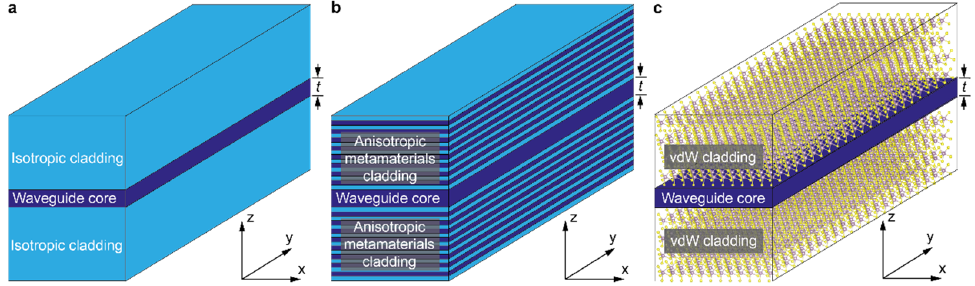
Figure 1. Variation of waveguide claddings. Planar waveguide with ( a ) isotropic, ( b ) anisotropic metamaterials, and ( c ) vdW cladding.